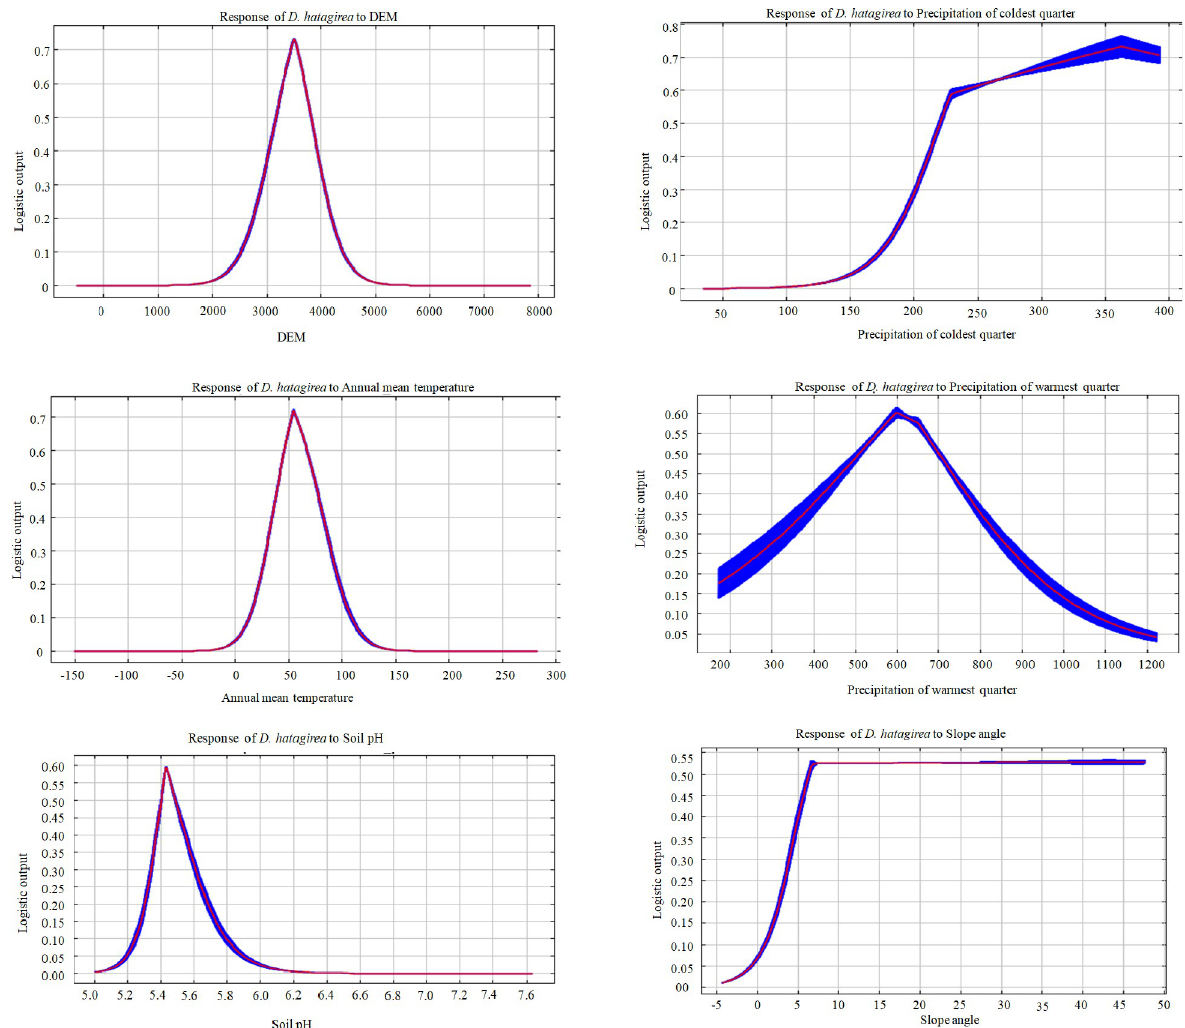
Fig 5. Response curves of six environmental predictors and their relationships with the probability of the target species suitability range.